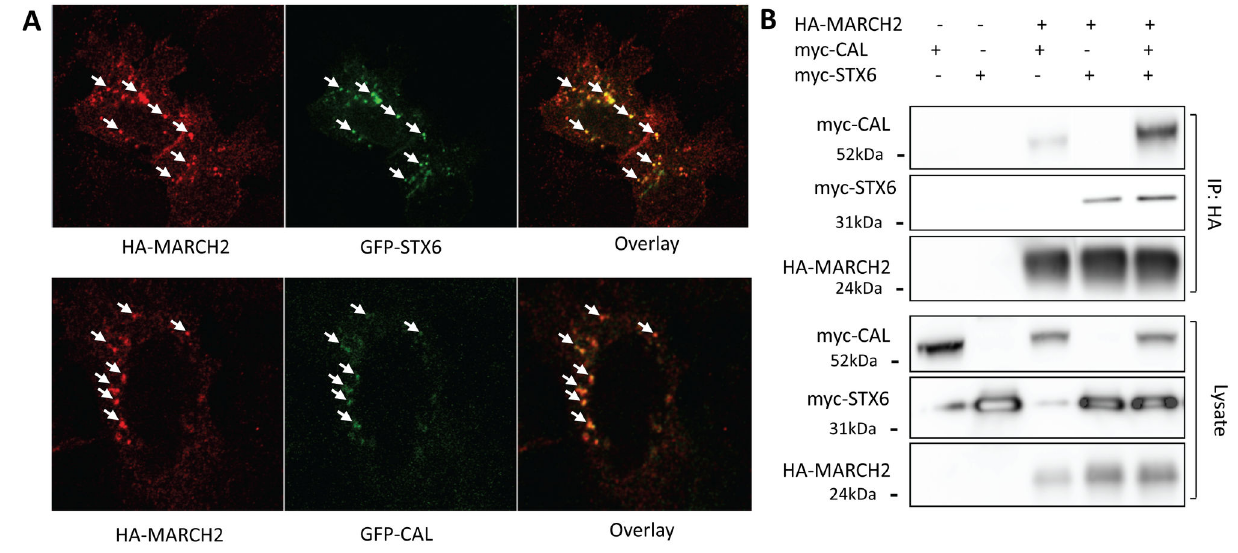
Figure 1. Co-localization and interaction of MARCH2 with STX6 and CAL. ( A ) HEK293 cells grown on coverslips were co- transfected with 3µg GFP-STX6 or 3µg GFP-CAL and 1µg HA-MARCH2. Twenty-four hours after transfection, cells were fixed and subjected to indirect fluorescent immunocytochemical staining with an anti-HA monoclonal antibody followed by Cy3-conjugated secondary antibody. HA-MARCH2 appears in red and GFP-STX6 and GFP-CAL are green. Arrow heads point to colocalization. ( B ) HEK293 cells were co-transfected with 3µg myc-CAL, 3µg myc-STX6, and 1µg HA-MARCH2 as indicated. After 48 h, cell lysates were harvested and immunoprecipitated with an anti-HA affinity matrix. Cell lysates and immunoprecipitated materials were subjected to immunoblot analysis with Myc or HA antibodies. Data shown are representative of at least three independent